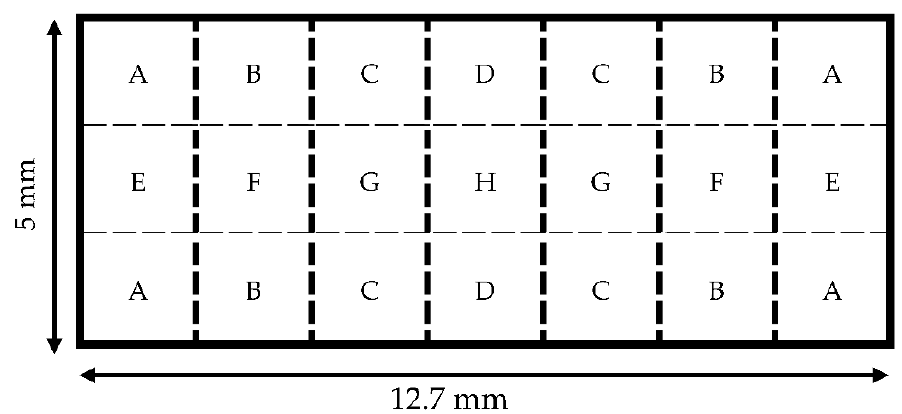
Figure 5. A diagram showing the 8 locations (A–H) where drops were deposited on the surface of each 12.7 mm × 5 mm sensor. Each letter represents a different location. With ‘H’ being at the origin center of the sensor, the rest of the letters (A–G) are mirrored across the four quadrants of the sensor surface to show symmetry.